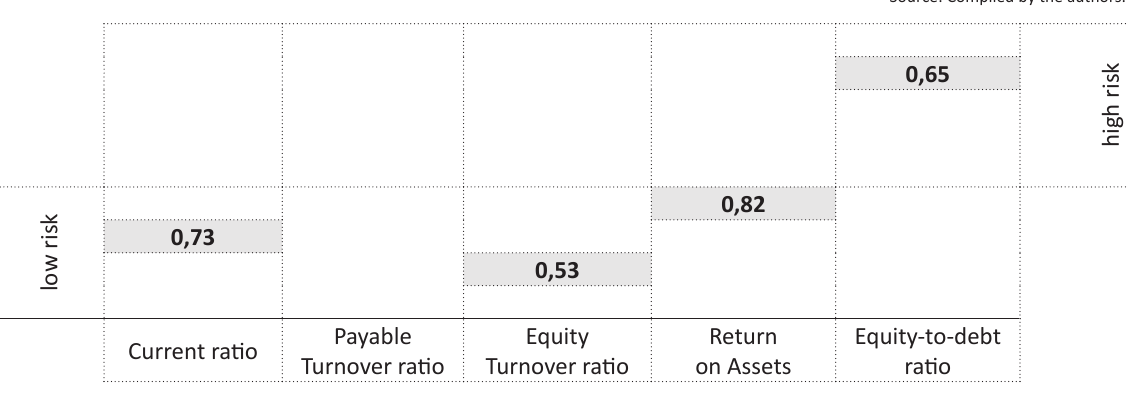
Figure 1. The matrix of normalized values of indicators